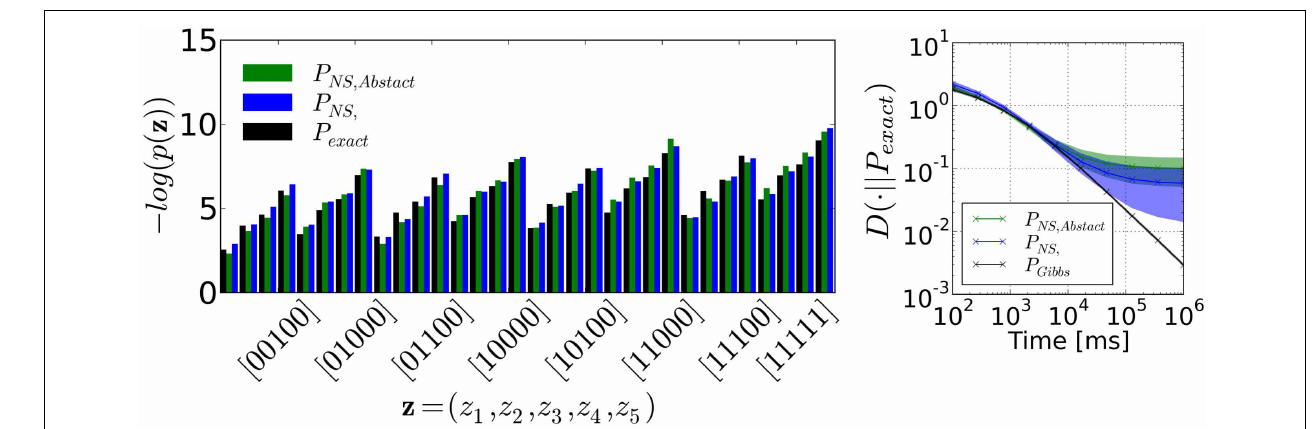
FIGURE 4 | (Left) Example probability distribution obtained by neural sampling of the RBM of Figure 3 . The bars are marginal probabilities computed by counting the events [ 00000 ] , [ 00001 ] ,..., [ 11110 ] , [ 11111 ] , respectively. P NS is the distribution obtained by neural sampling and P is the exact probability distribution computed with Equation (4). (Right) The degree to which the sampled distribution resembles the target distribution is quantified by the KL divergence measured across 48 different distributions, and the shadings correspond to its standard deviation. This plot also shows the KL divergence of the target distribution sampled by Gibbs Sampling